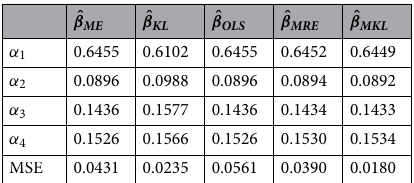
Table 2. Estimated